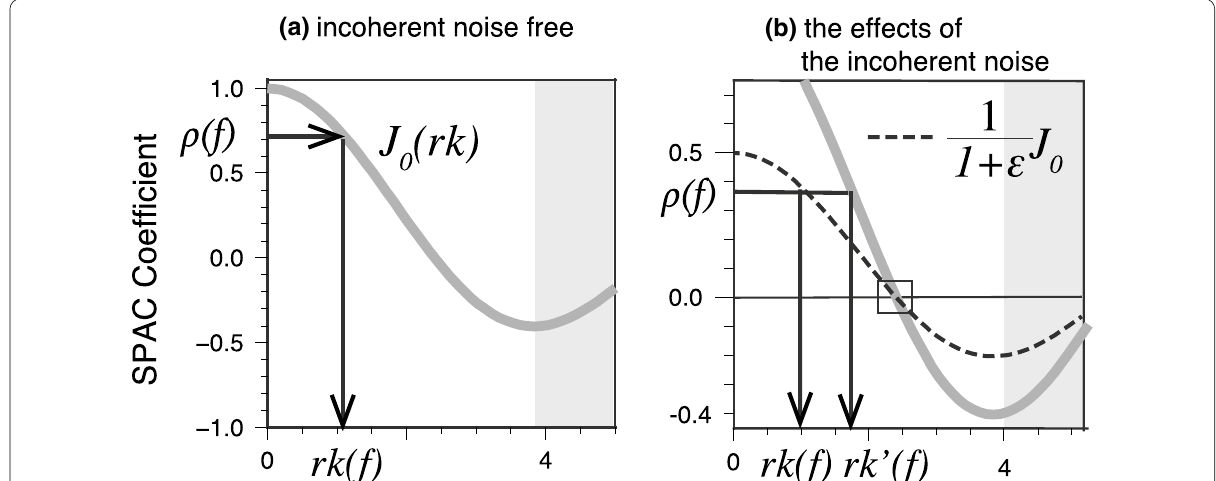
Fig. 7 a Schematic diagram of determining the value of rk from the SPAC coefficient through the model function. The grey curve represents the model function of J 0 ( rk ) . b SPAC coefficient curve affected by incoherent noise (broken line). rk is overestimated (i.e., rk ′ in the figure) in the rk range less than 2.6 when incoherent noise is present. The shaded regions in each diagram represent the rk range larger than 3.8 (i.e., out of the search range for rk